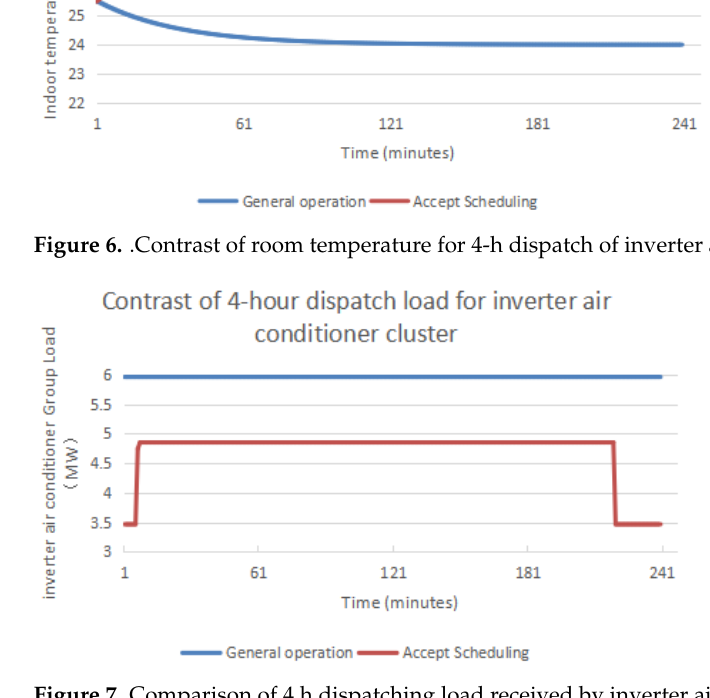
Figure 7. Comparison of 4 h dispatching load received by inverter air conditioning cluster.